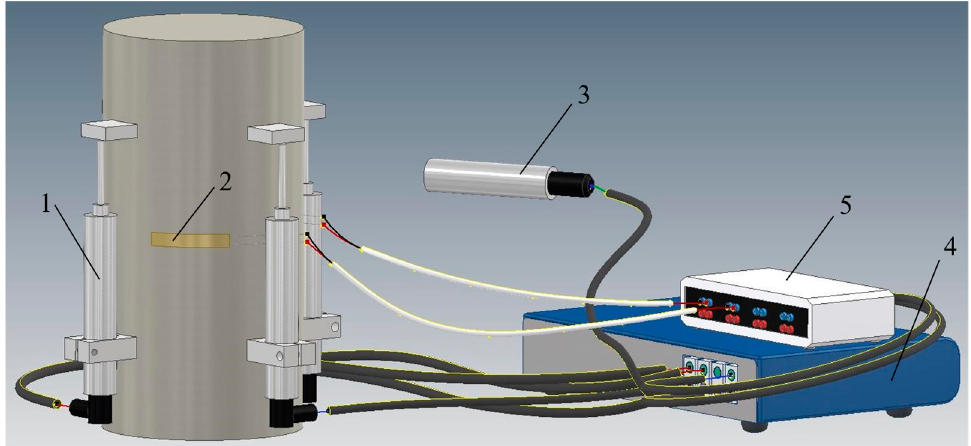
Figure 3. Measurement device system: 1. LDT devices; 2. SG sensors; 3. load sensor; 4. data logger; 5. Wheatstone bridge.